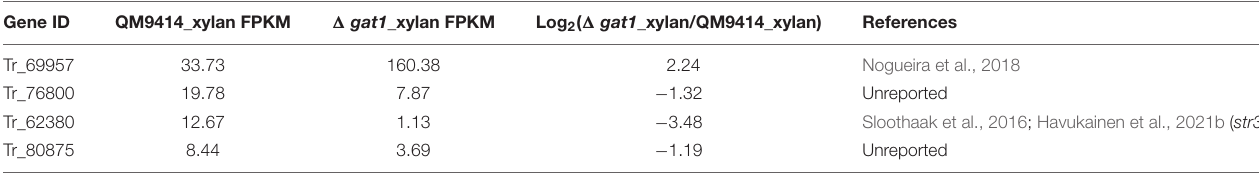
TABLE 4 | Sugar transporter encoding genes with differential expression between (cid:49) gat1 and QM9414 on xylan.